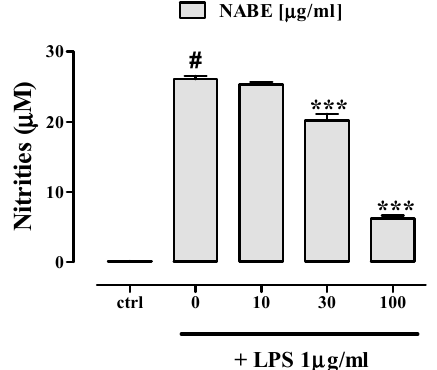
Figure 1. Inhibitory effect of Nepeta asterotricha n- butanol extract (NABE) on nitrite levels in the cell medium of J774A.1 macrophages stimulated with lipopolysaccharide (LPS, 1 μ g/mL) for 24 h. NABE, at the concentration range of 10–100 μ g/mL, were added to the cell media 30 min before LPS stimulus. Results are expressed as mean ± SEM of three experiments (in triplicates). # p < 0.001 vs control (ctrl); *** p < 0.001 vs. LPS alone.